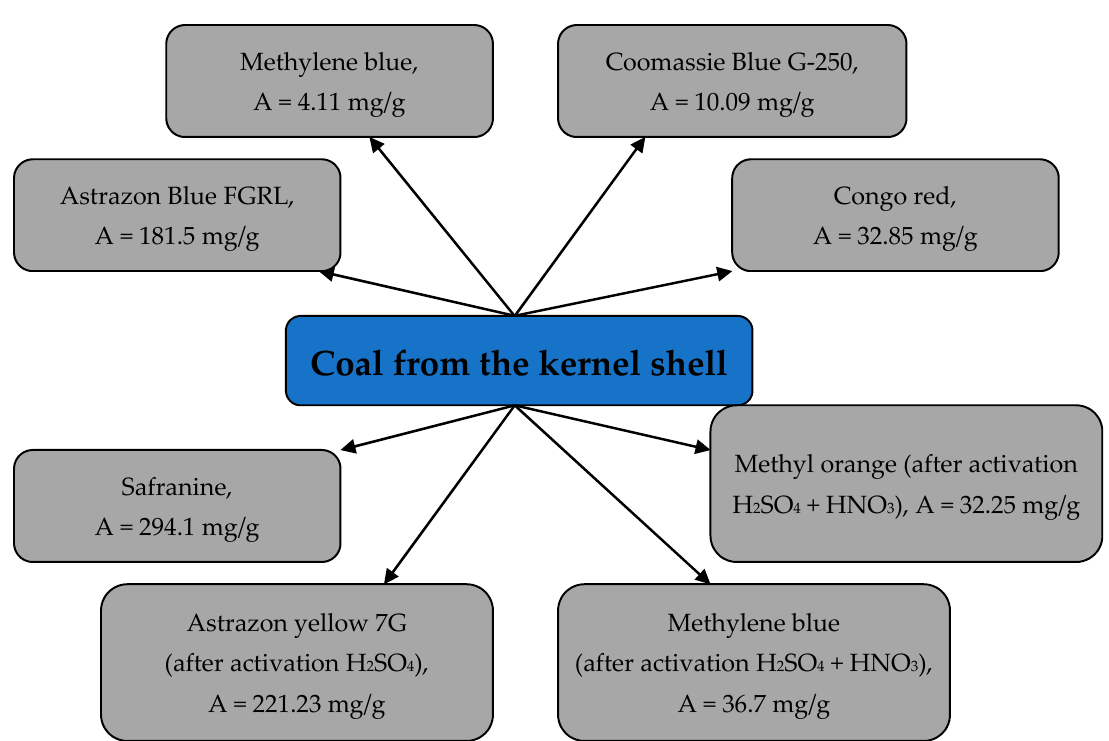
Figure 11. Dyes extracted from aqueous solutions with activated charcoal from apricot kernel shells.